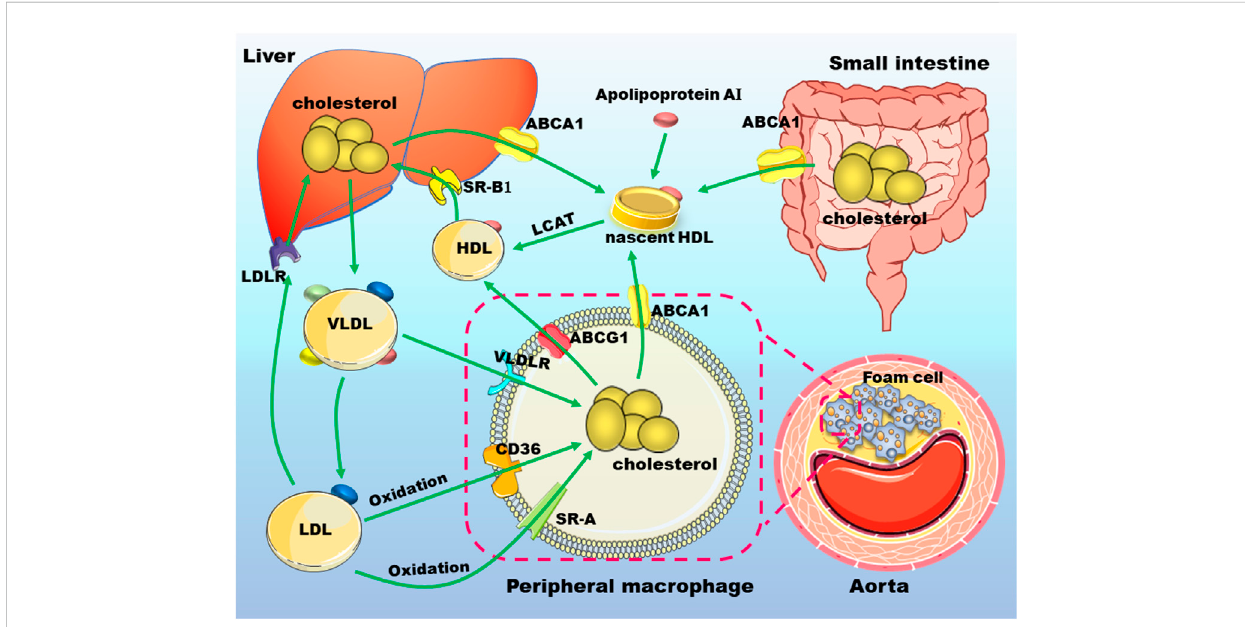
FIGURE 1 Cholesterolmetabolismandmacrophagesinatherosclerosis.Nascenthigh-densitylipoprotein(HDL)particlesderivedfromapolipoproteinA-I(apo A-I) that is secreted either by liver or small intestine, uptake cholesterol from different cell types, including macrophages via ATP binding cassette transporter (ABC) A1. ABCG1 mediates cholesterol transport from peripheral cells to mature HDL. HDL-cholesterol can be esteri fi ed by lecithin- cholesterol acyltransferase (LCAT) to promotetheformation of mature HDL. HDLis absorbed by hepatocytes mainlyby scavenger receptor, class B type 1 and is metabolized in the liver. Hepatic synthesized very low-density lipoprotein (VLDL) particles can be transformed to low-density lipoprotein (LDL). These lipoproteins can be uptake by macrophages through receptors such as VLDL receptor (VLDLR), cluster of differentiation 36 (CD36), scavenger receptor A (SR-A). The excess accumulation of lipids in macrophages under the arterial endothelium will promote the occurrence and development of atherosclerosis. These abbreviations are suitable for the following fi